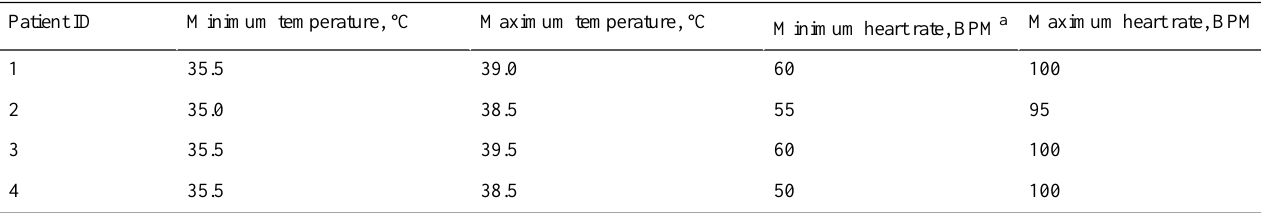
Table 3. Defining the anomaly thresholds of temperature and heart rate sensors for each